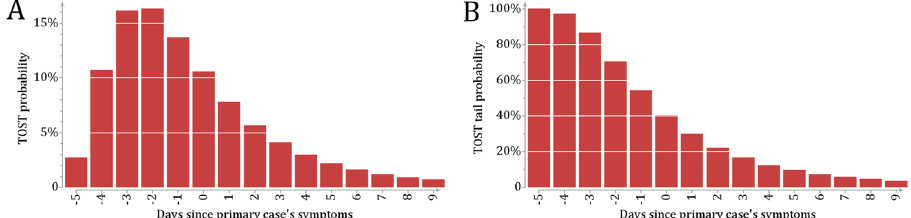
Figure 4. Timing of transmission. The figure shows the distribution of the time from symptom onset to transmission (TOST). ( A) The estimated TOST distribution based on the observed serial intervals in 1016 transmission pairs. The figure presents the posterior predictive probabilities for transmission occurring on day t = − 5, . . . , 9 , since symptom onset. ( B ) The tail probabilities of the TOST distribution. This is interpreted as the probability that transmission occurs after day t = − 5, . . . , 9 , since symptom